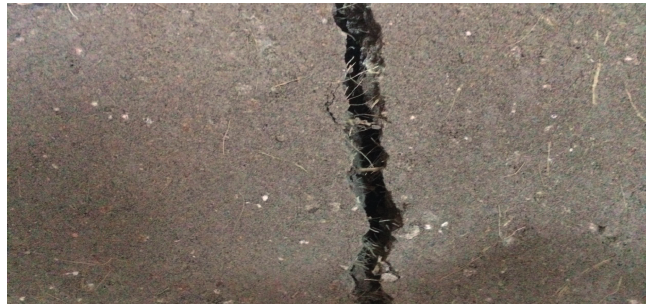
Figure 10. Banana fibers bridging the GCEB cracks during